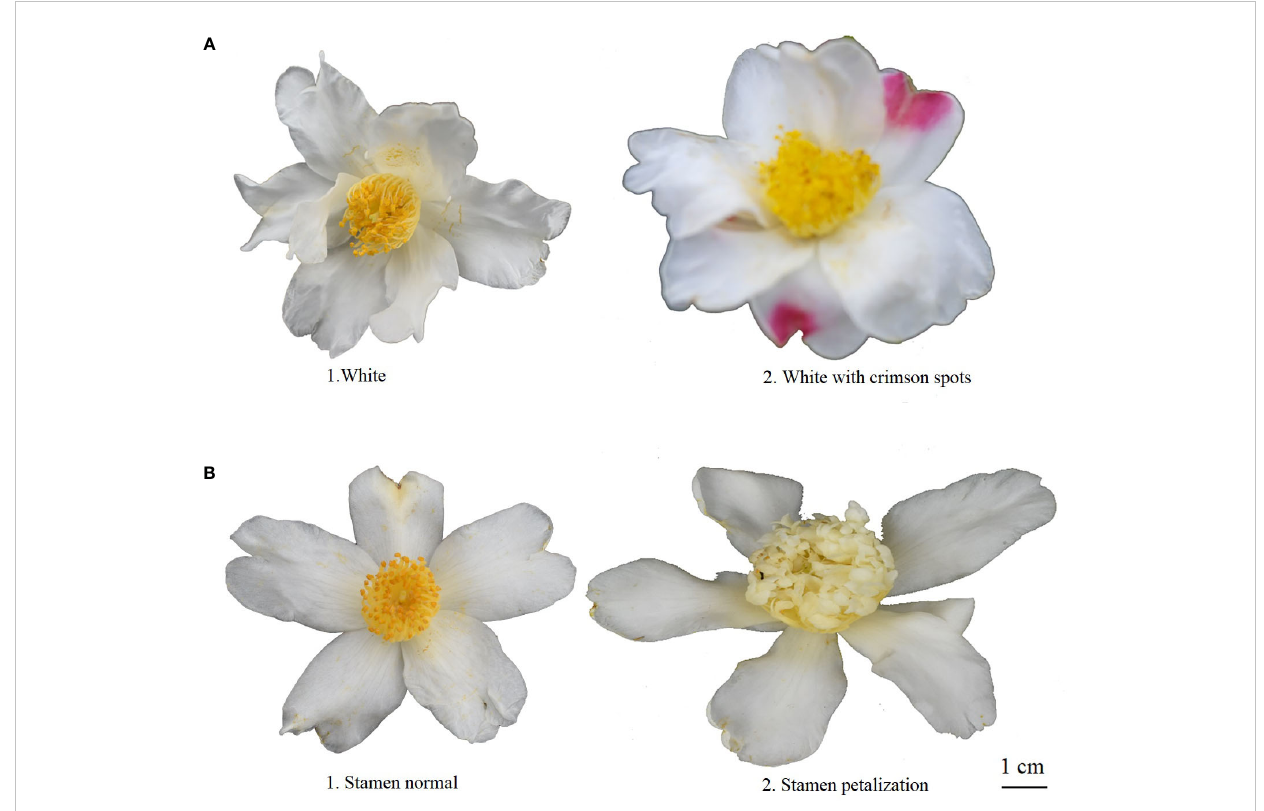
FIGURE 3 Rating of fl ower morphologic characters for wild C. oleifera germplasm resources: (A) petal color and (B) stamen